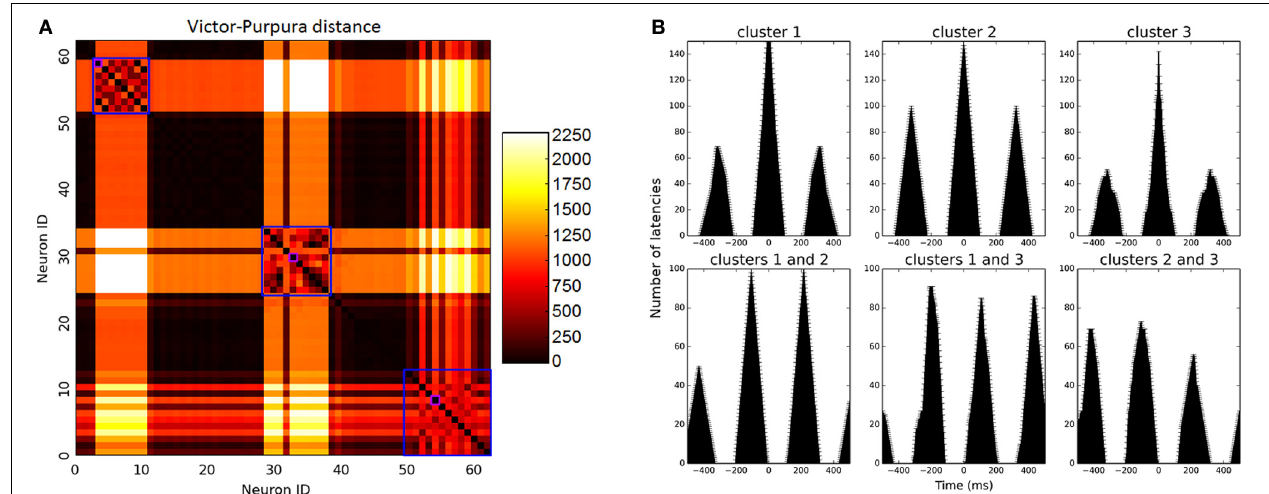
FIGURE 5 | Firing pattern analysis. (A) Matrix of Victor-Purpura distance between each neuron to all others. Clusters were identified using MOG algorithm, marked on the figure in blue squares. Of each cluster, the most active unit was selected to represent firing rate, marked in purple for illustration. (B) Firing analysis of a sample 64 neuron network. Upper row depicts auto-correlation of neurons from 3 prominent clusters (i.e.,